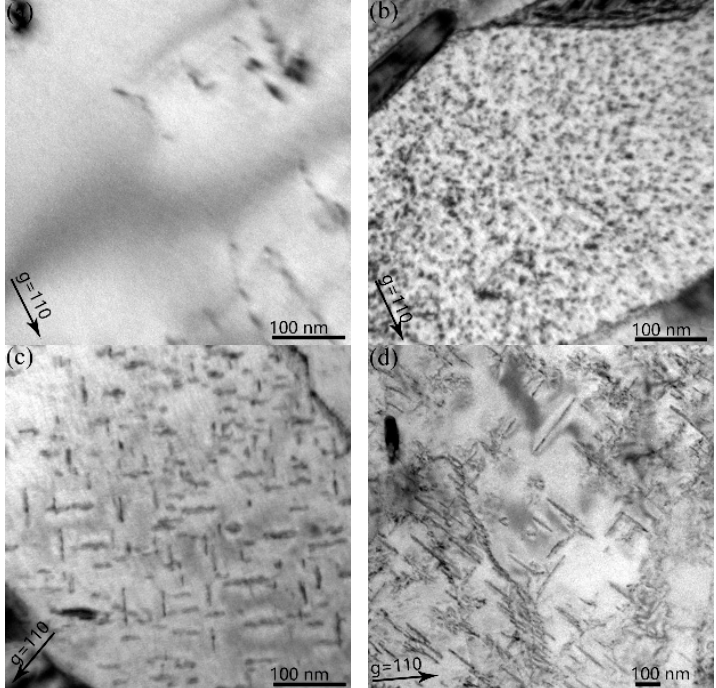
Figure 3. TEM bright field micrographs of specimens irradiated with H + of different fluences at 723 K (( a ) 1 × 10 20 H + • m − 2 ; ( b ) 2 × 10 20 H + • m − 2 ; ( c ) 3 × 10 20 H + • m − 2 ; ( d ) 5 × 10 20 H + • m − 2 ). All of the micrographs were observed at g = 110 near the pole [001].